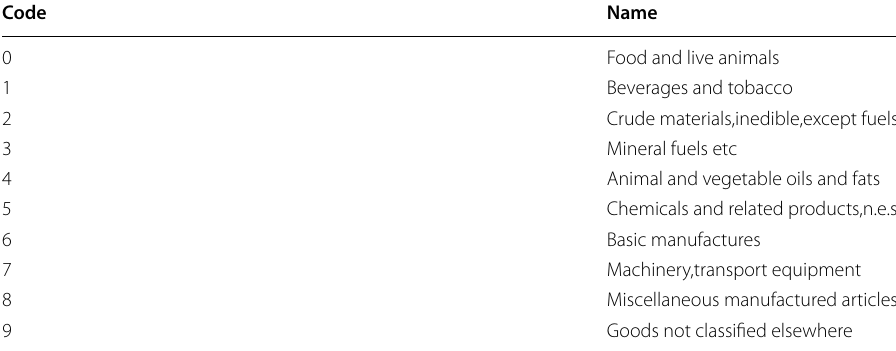
Table 1 Product code and name for SITC classification level 1